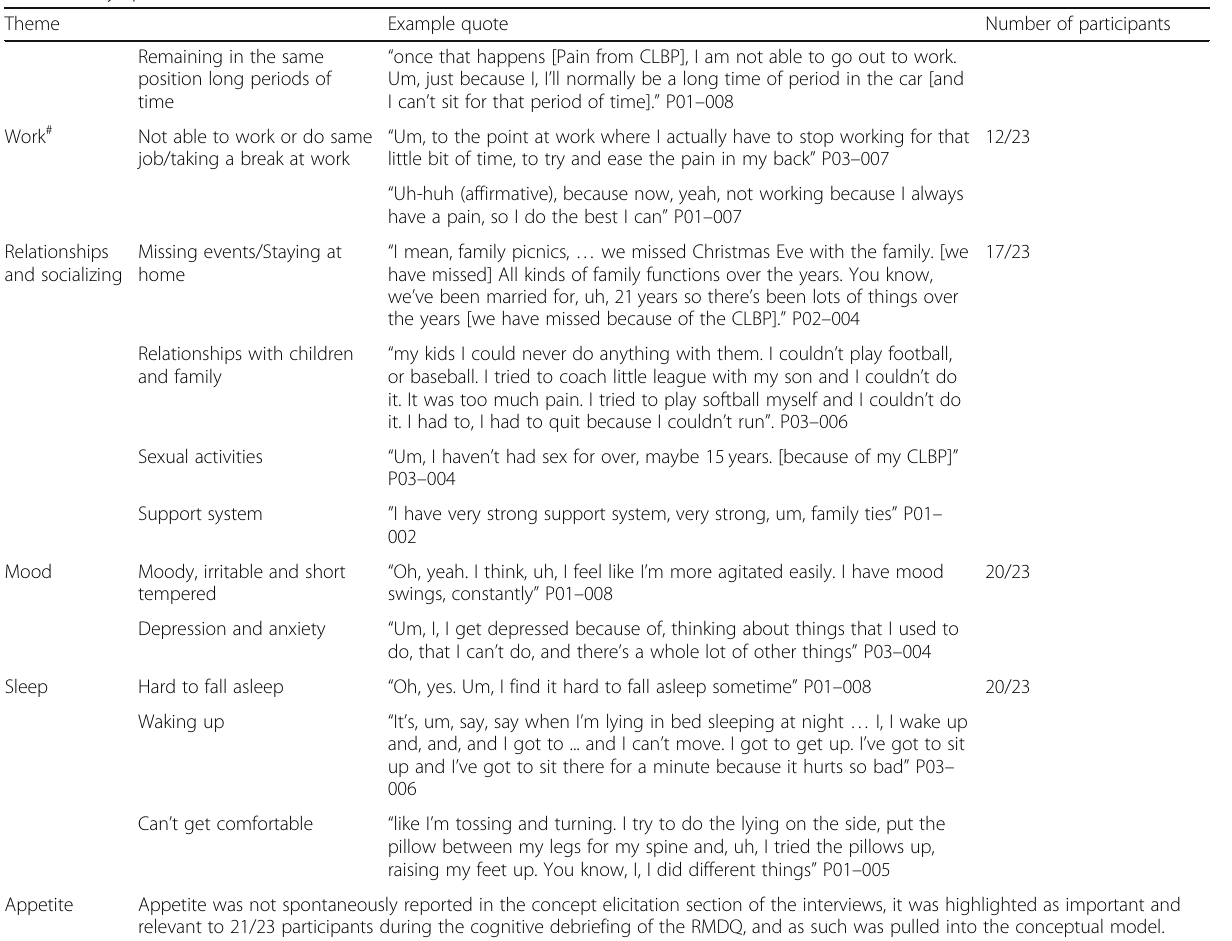
Table 2 Key qualitative themes